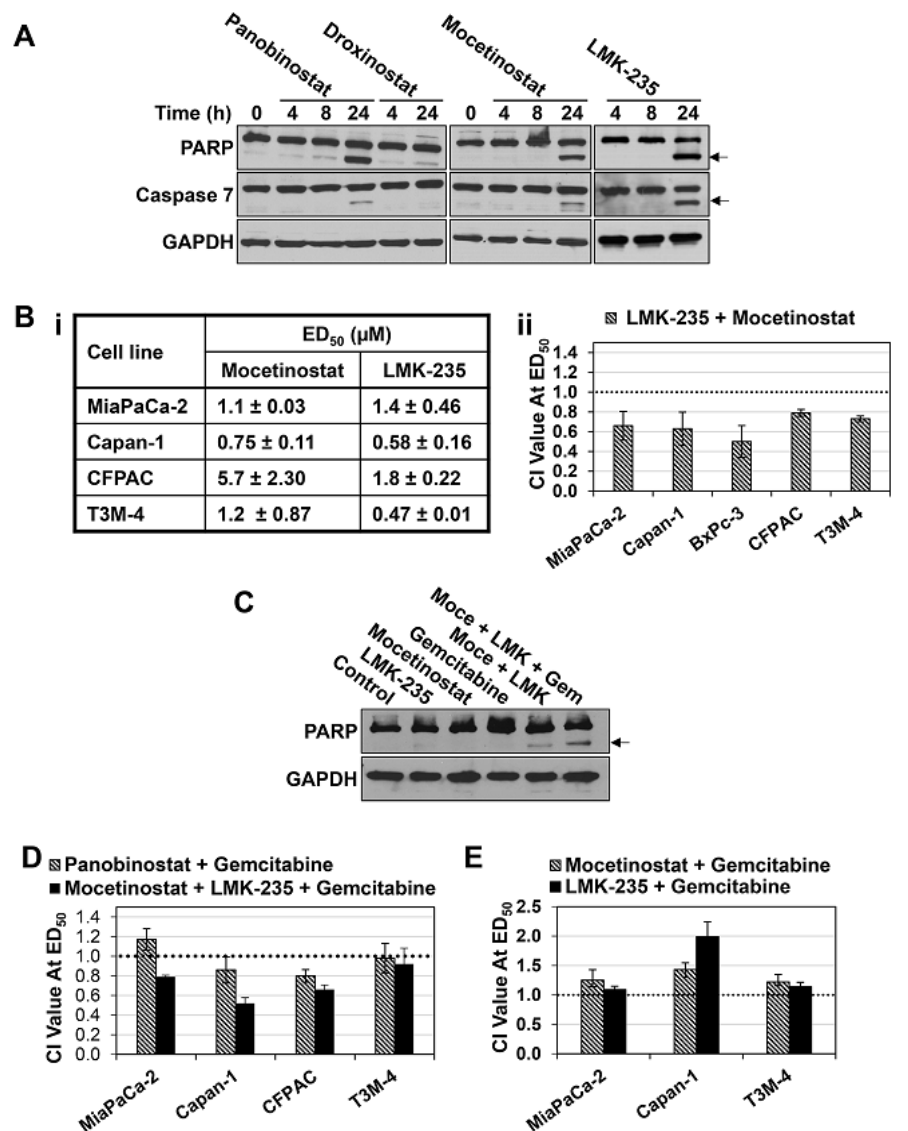
Figure 1. Synergistic interactions of Mocetinostat, LMK-235, and gemcitabine in pancreatic ductal adenocarcinoma (PDAC) cells. ( A ) MiaPaCa-2 cells treated with 100 nM Panobinostat, 10 µM Droxinostat, 10 µM Mocetinostat, or 10 µM LMK-235 for the indicated times and analyzed for poly (ADP-ribose) polymerase (PARP), caspase 7, and GAPDH expression by Western blotting. Arrow indicates the migration of cleaved proteins. ( B.i ) ED 50 values for Mocetinostat and LMK-235 in pancreatic cancer cell lines. ( B.ii ) The indicated cell lines were treated with LMK-235, Mocetinostat, or a combination of LMK-235 and Mocetinostat at a constant ratio. After 72 h, 3-(4,5 Dimethylthiazol-2-yl)-2,5-diphenyltetrazoliumbromide (MTT) assays were performed, and the combination index (CI) value for the combination treatment is presented. Dotted line indicates CI value of one, which divides synergistic interaction (CI < 1) from antagonistic interaction (CI > 1). ( C ) Capan-1 cells were treated with LMK-235 (LMK, 600 nM), Mocetinostat (Moce, 1 µM), and/or gemcitabine (Gem, 80 nM) for 24 h, and expression of the indicated proteins was analyzed by Western blotting. Arrow indicates the migration of cleaved PARP. ( D , E ) As in B except that cells were treated with the indicated drugs either alone or in combination at equal ratios. Data are representative ( A , C ) or means ± s.e. ( B , D , E ) of at least three independent experiments.